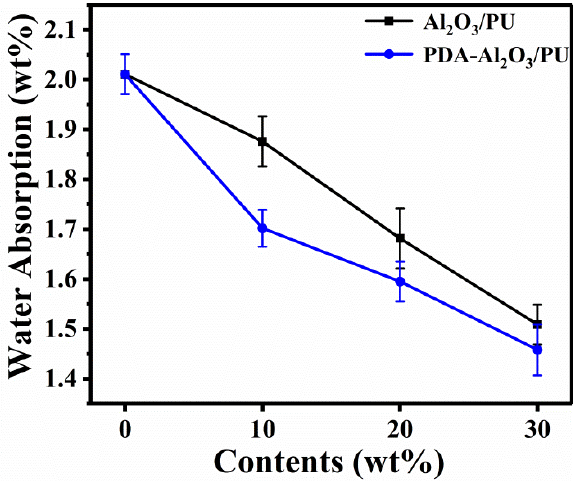
Figure 12. Water absorption of Al 2 O 3 /PU and PDA-Al 2 O 3 /PU composites.